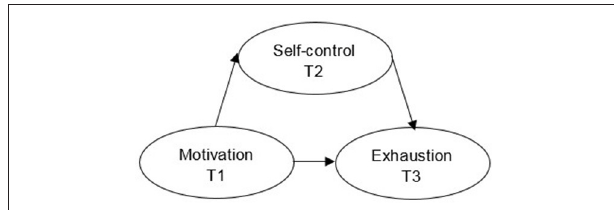
FIGURE 1 | The structural simple longitudinal mediation model. T1, T2, and T3 = time point one, two, and